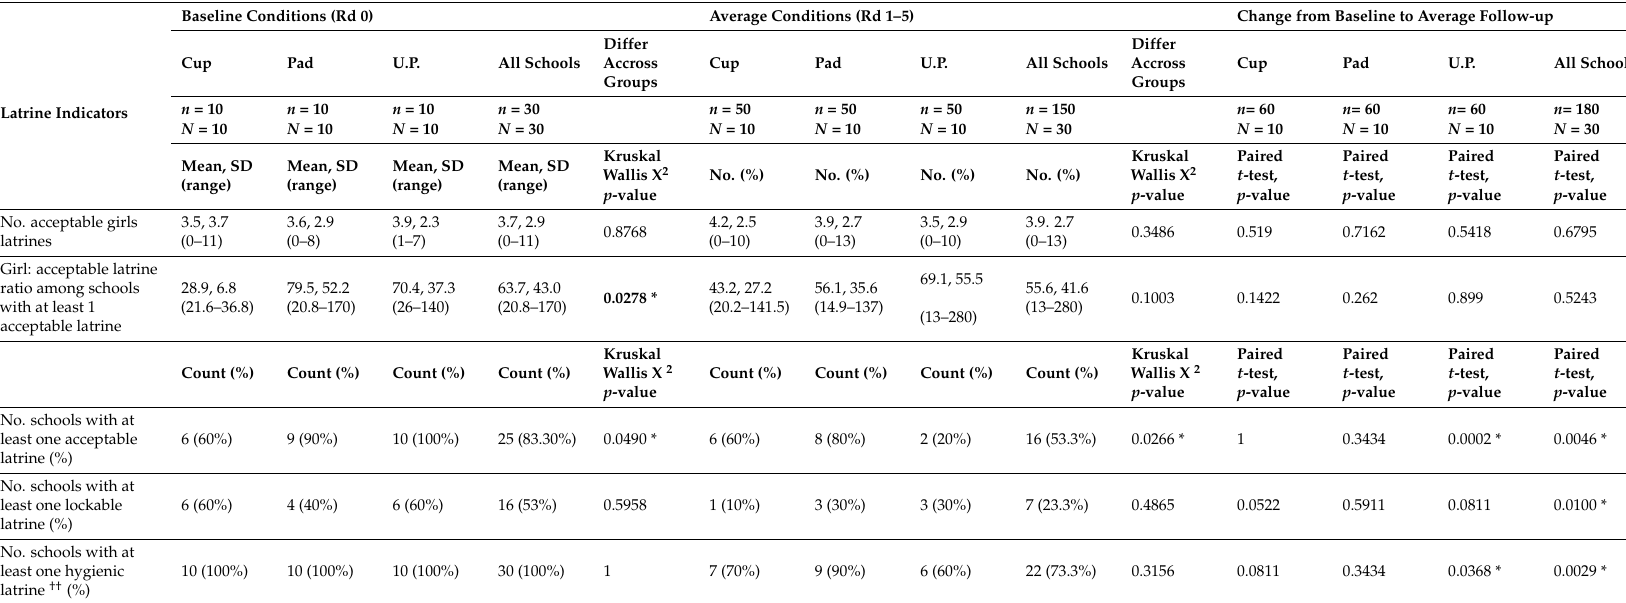
Table 2. Girls’ latrines across arms, baseline and average over five follow-up rounds in schools in western Kenya